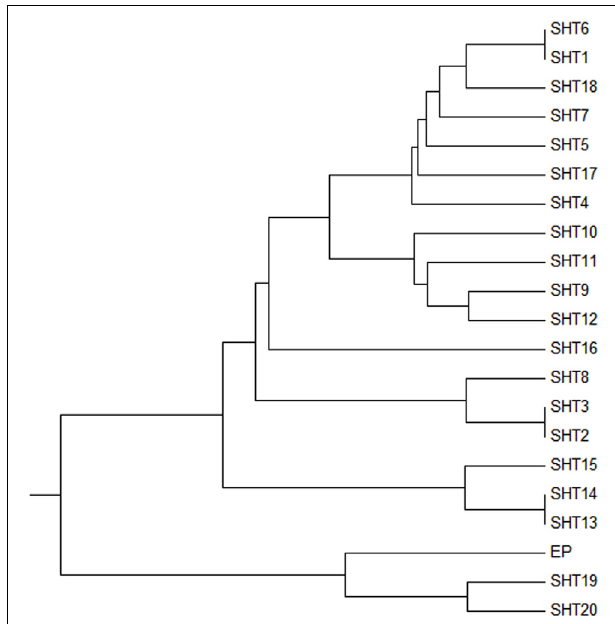
FIGURE 3 | UPMGA clustering dendrogram based on DNA genetic distance among 21 haplotypes formed with 14 ECAY segregating sites.